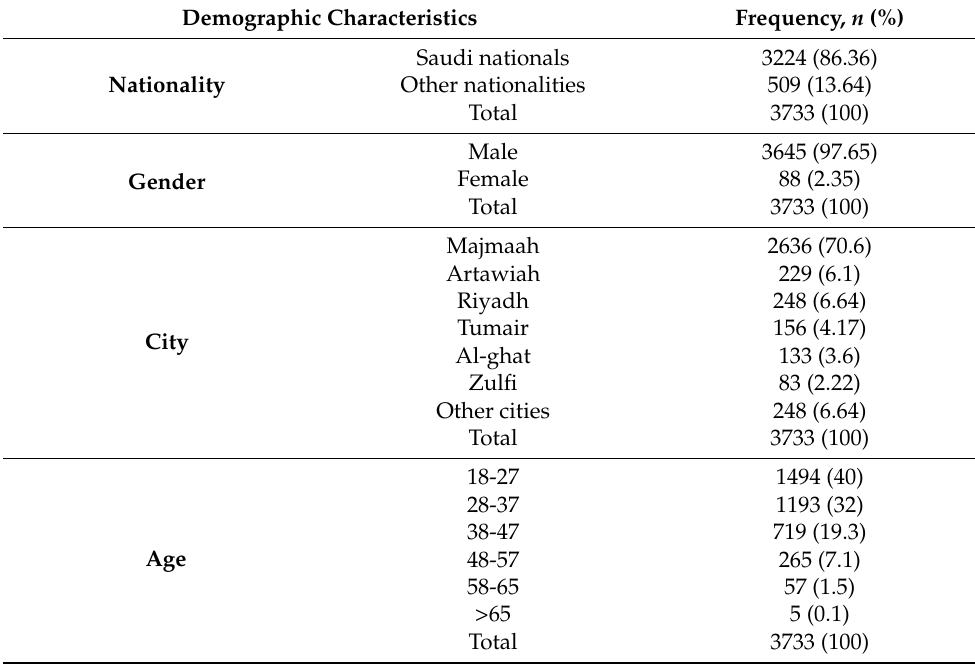
Table 1. Demographic characteristics of blood donors who donated blood at KKGH in Al Majmaah city or at the associated blood donation camps in other cities of the region, from January 2019 to